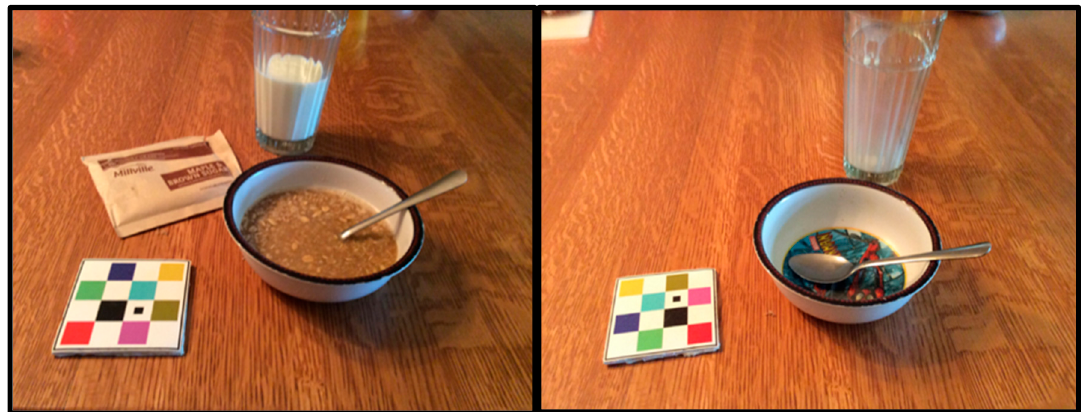
Figure 1. Before and after Mobile Food Record ™ images with the fiducial marker.